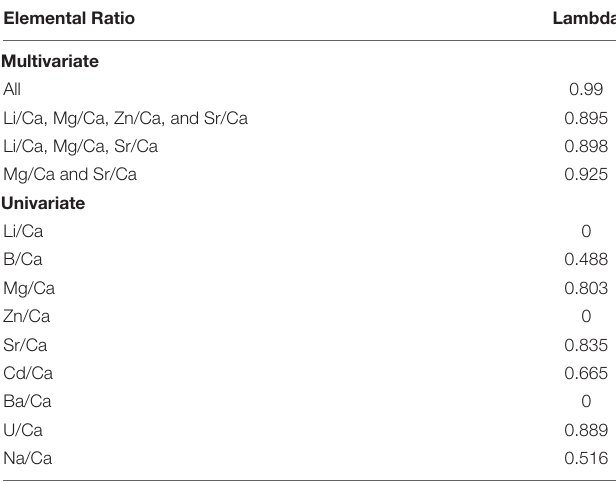
TABLE 7 | Estimates of phylogenetic signal for X/Ca